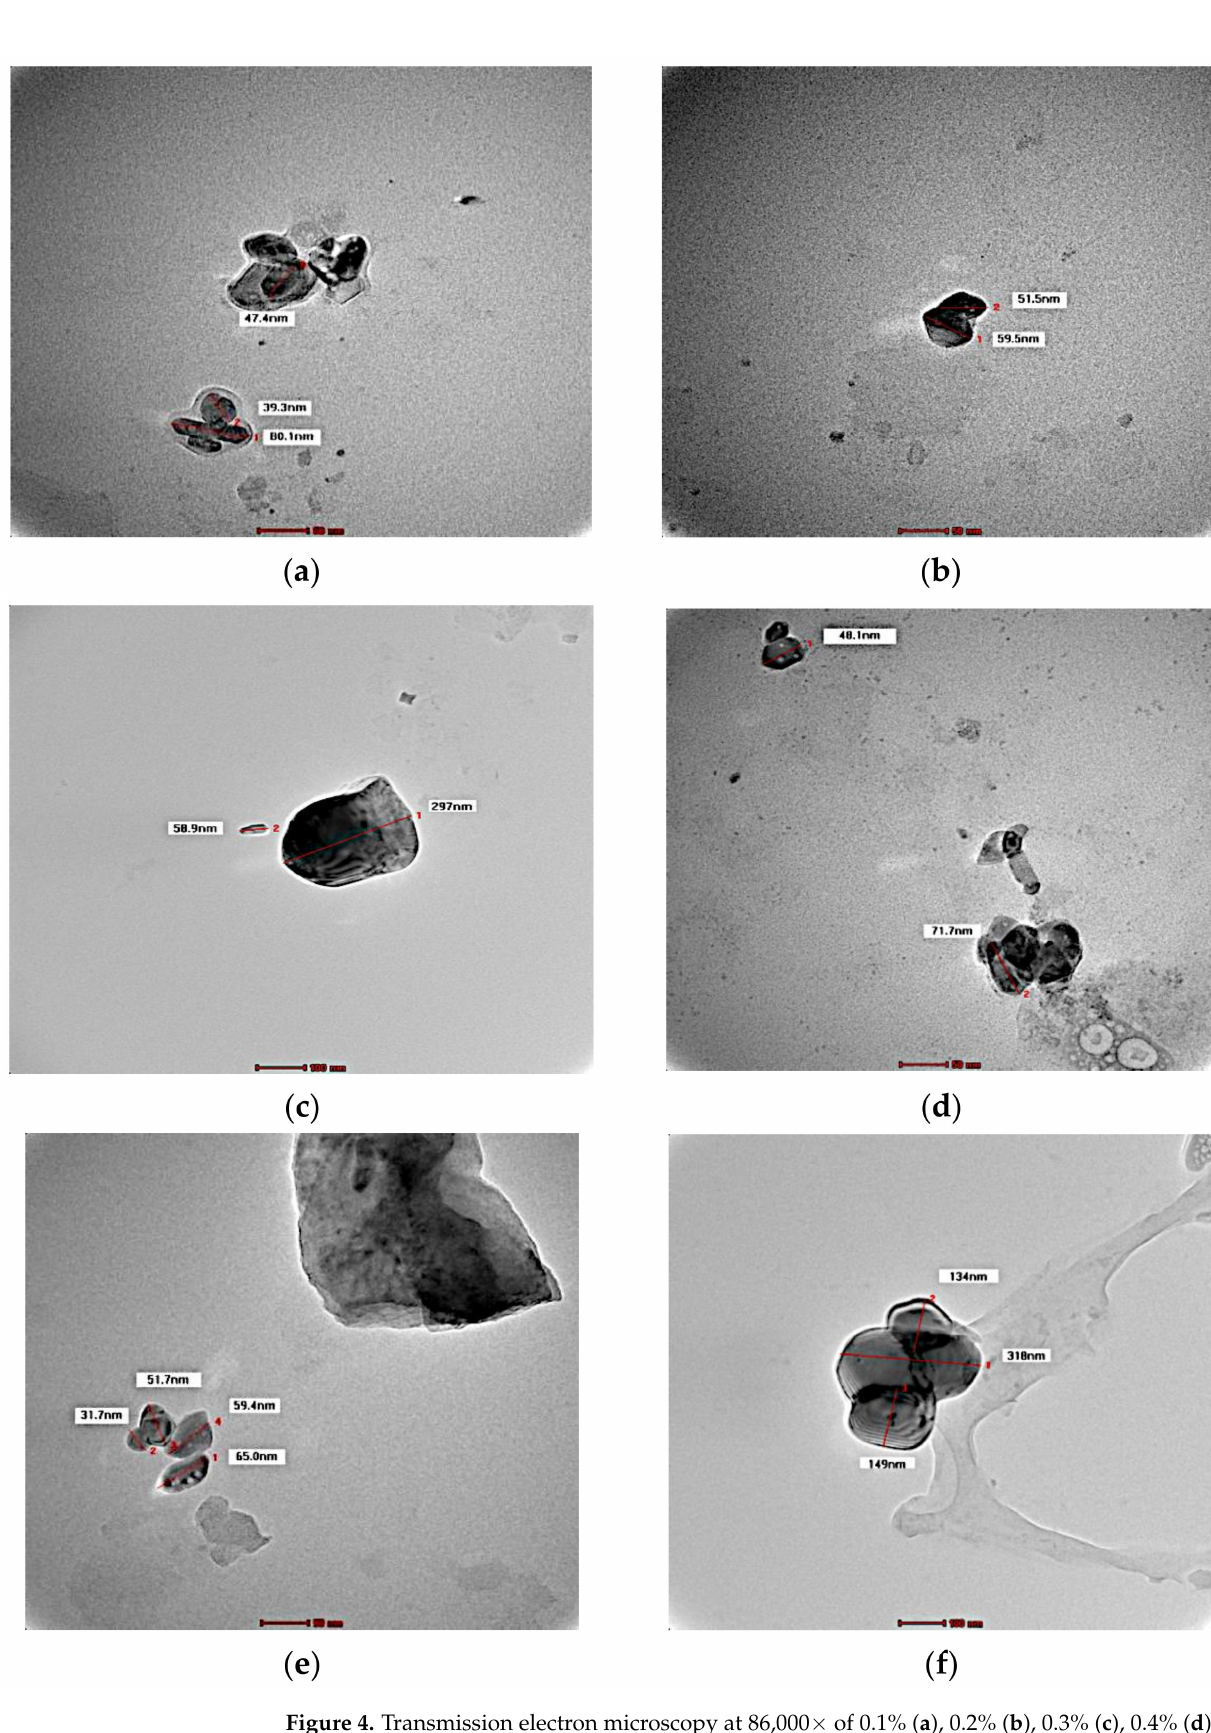
Figure 4. Transmission electron microscopy at 86,000 × of 0.1% ( a ), 0.2% ( b ), 0.3% ( c ), 0.4% ( d ), 0.5% ( e ), and 0.6% ( f ) β -arbutin